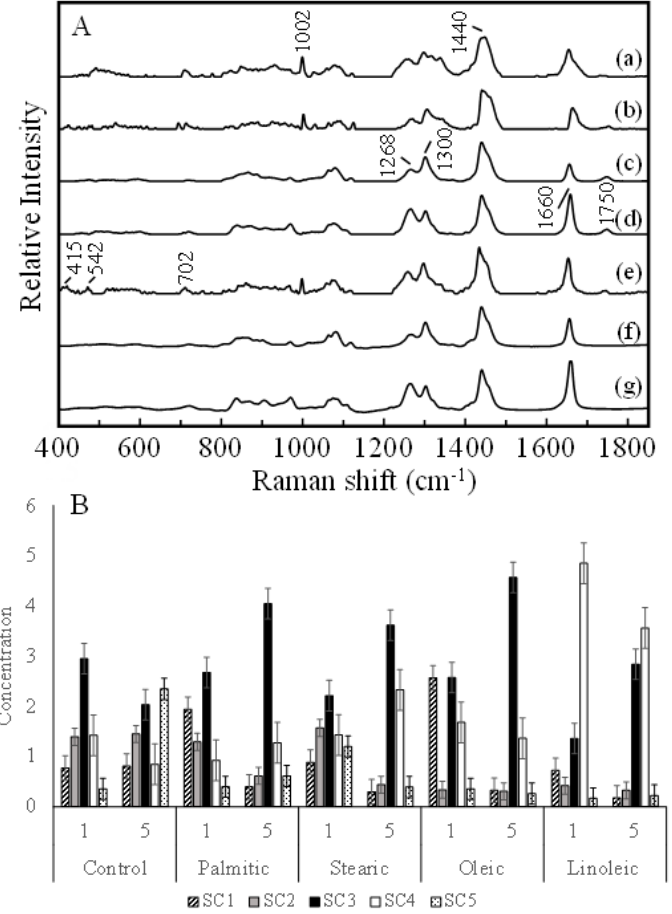
Figure 5. Results of MCR-ALS analysis. The five major components (a–e) obtained by MCR analysis ( A ) were compared with the spectra of pure oleic (f) and linoleic (g) acids. The ALS scores of the five components ( B ) are exhibited for the spectra of the cells cultured without fatty acids and those cultured with palmitic, stearic, oleic, and linoleic acids.